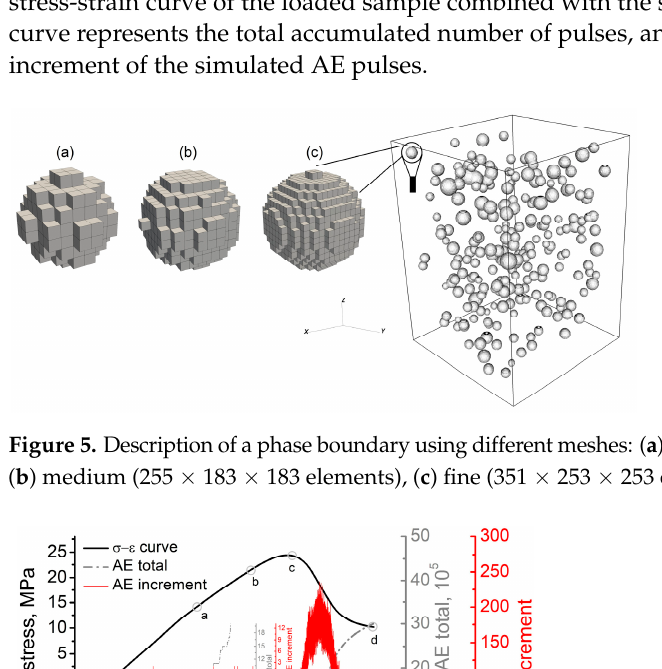
Figure 4. Verification of the numerical solution convergence: ( a ) stress-strain curves for models with different number of mesh elements, ( b ) peak stress of obtained stress-strain curves against the number of mesh elements.